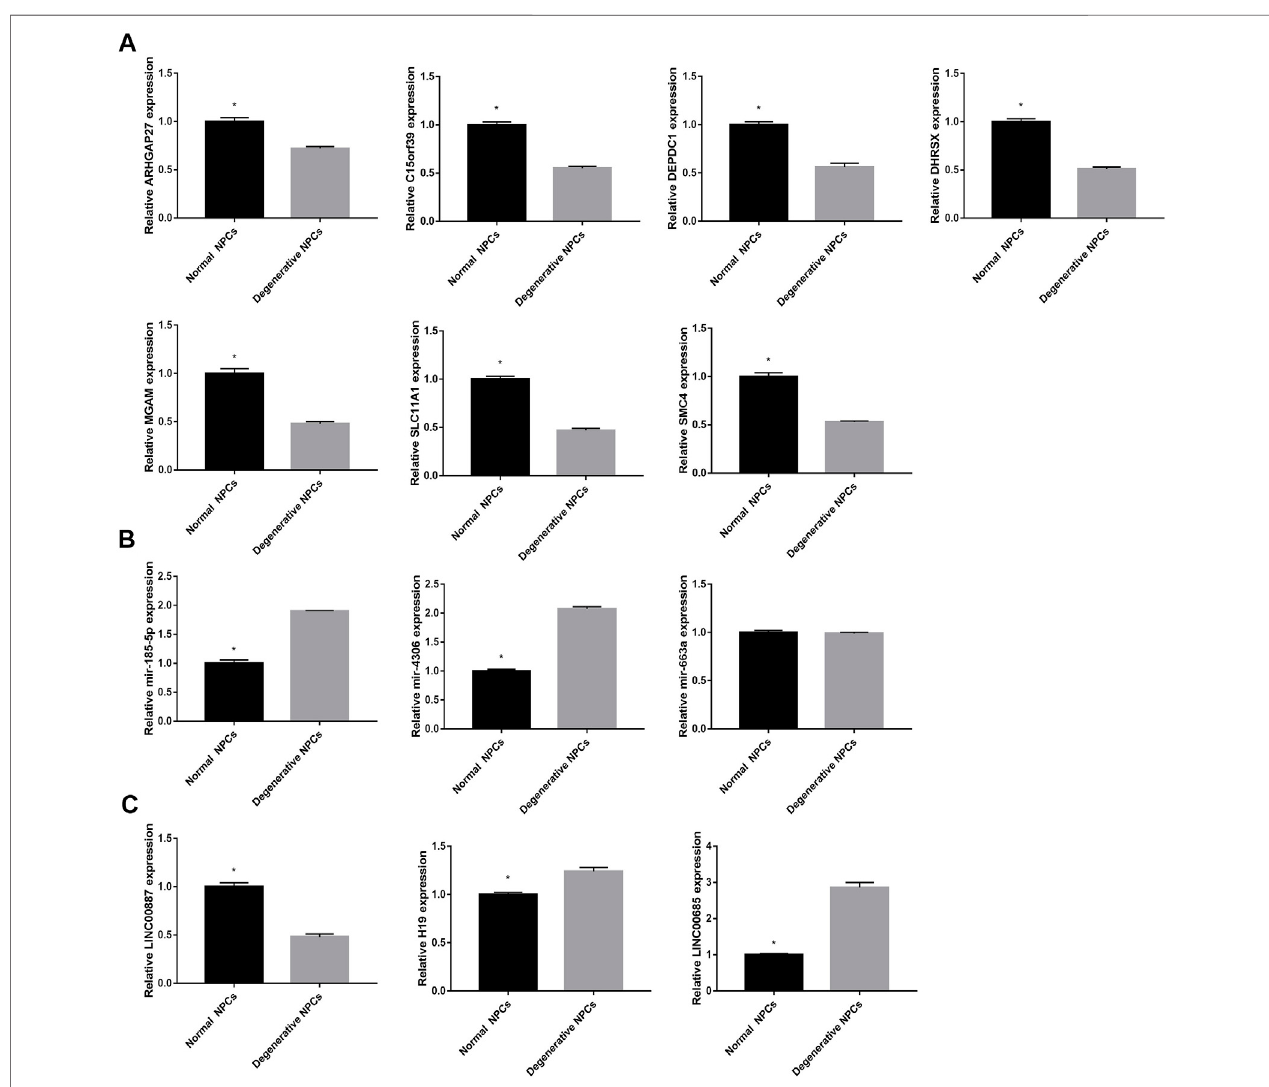
FIGURE 11 | Expression level of hub DEGs in normal and degeneration NPCs. (A) Expression level of mRNAs in normal and degeneration NPCs. (B) Expression level of miRNAs in normal and degeneration NPCs. (C) Expression level of lncRNAs in normal and degeneration NPCs. * p < 0.05.